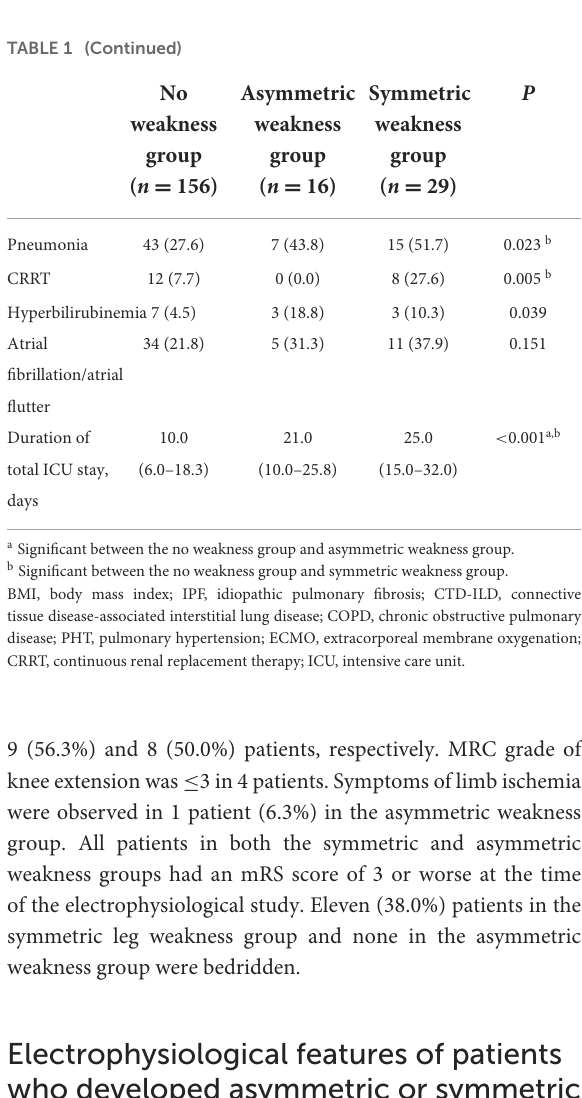
leg weakness after LT In the nerve conduction study, the amplitudes of peroneal CMAPs recorded from the extensor digitorum brevis muscle were abnormal in all patients with asymmetric and symmetric weakness (Table 3). The rate of reduced posterior tibial CMAP was significantly higher in the symmetric weakness group (96.6%) than in those with asymmetric weakness (68.8%, p = 0.017). In contrast, more patients in the asymmetric weakness group (68.8%) had decreased amplitudes of superficial peroneal SNAP compared to the symmetric weakness group (34.5%, p = 0.027). In the asymmetric leg weakness group, the presumed site of nerve injury was the lumbosacral plexus in eight (50.0%) patients, peroneal nerve in four (25.0%) patients, sciatic nerve in two (12.5%) patients, and femoral nerve in two (12.5%) patients. In electromyography, abnormal spontaneous activities were observed in tibialis anterior muscle in 14 (87.5%) patients, medial